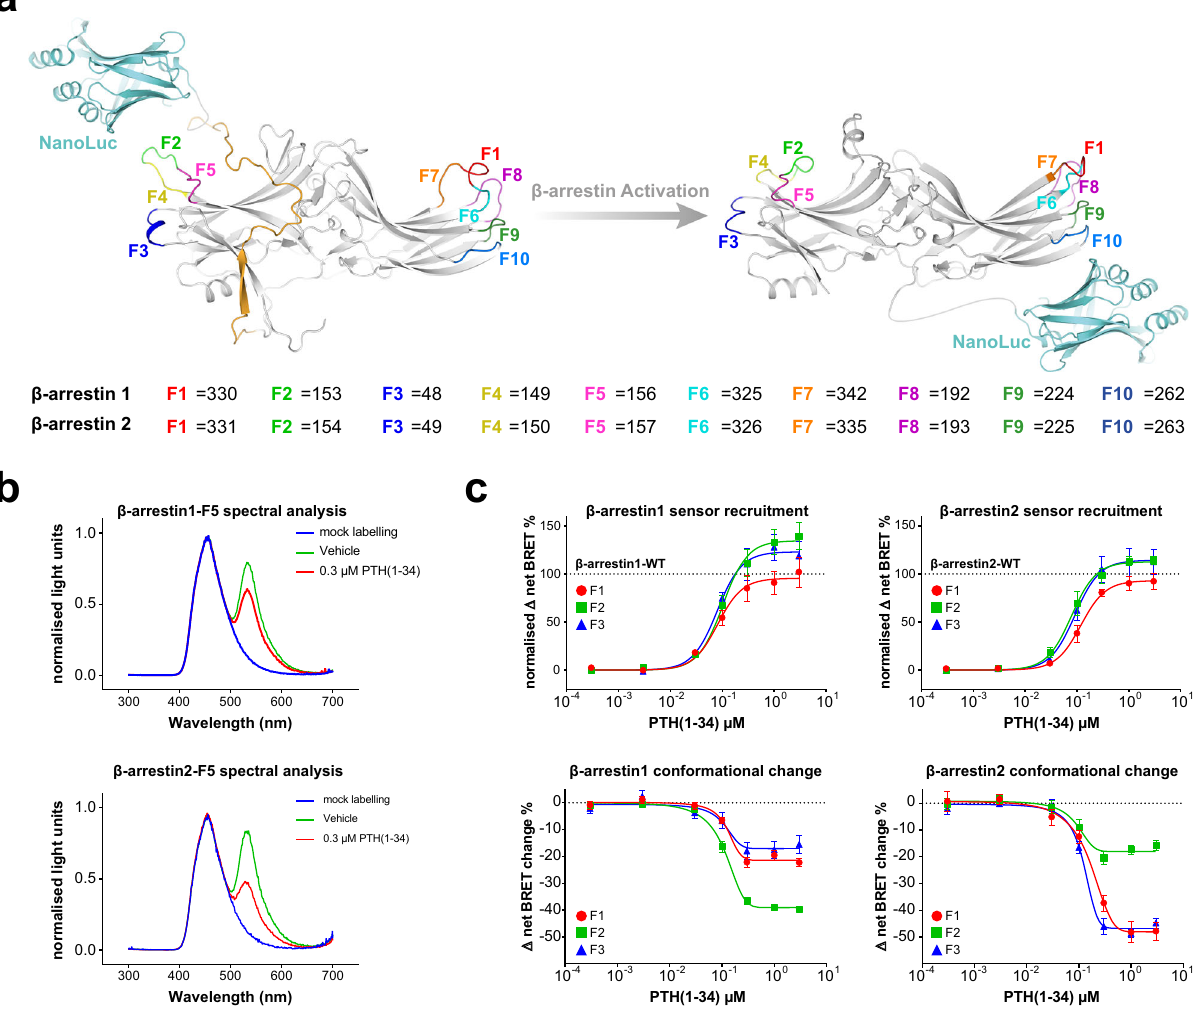
Fig. 2 | Generation and functionality of β -arrestin1 and 2 NanoBRET con- formational change biosensors. a Overall sensor design of intramolecular β - arrestin1 and 2 conformational change biosensors. The NanoLuc BRET donor is geneticallyfusedtothearrestinC-terminusandindividualFlAsH-bindingmotifsare introducedattendifferent positionsinoutward-facing loopsof the arrestinN-and C-domains (F1 – F10, coloured loops and amino acid sequence positions denoted for β -arrestin-1 and 2). In the inactive state (PDB: 1CF1, with a modelled C-terminus depicted in ochre), the NanoLuc is in close proximity of the individual FlAsH- binding motifs, resulting in an ef fi cient energy transfer. Upon GPCR- and sub- sequent arrestin activation (PDB: 5W0P), the distance between the BRET pair changes, depending on the nature of the conformational change and the speci fi c labelling position. b Characterisation of β -arrestin1/2-F5 conformational change biosensors. Shown are the emission spectra of the F5 conformational change bio- sensors for β -arrestin1 and 2. The spectra were measured with and without FlAsH labelling (mock, blue), in the basal state (vehicle, green) and after ligand addition